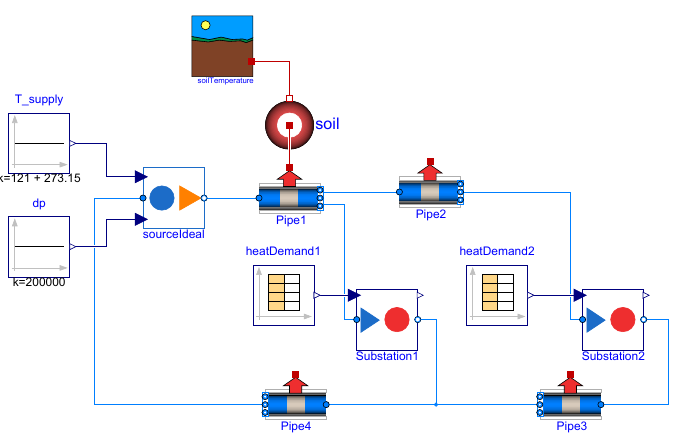
Figure 5. Exemplary system model of a district heating network with one heat supply, two substations, and four pipes. One pipe is exemplary connected with the RC model of the surrounding